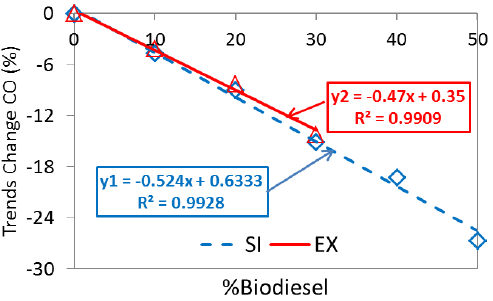
Figure 13. Trend of changes CO emissions according to biodiesel blend ratio of simulation (SI) and experiment (EX).